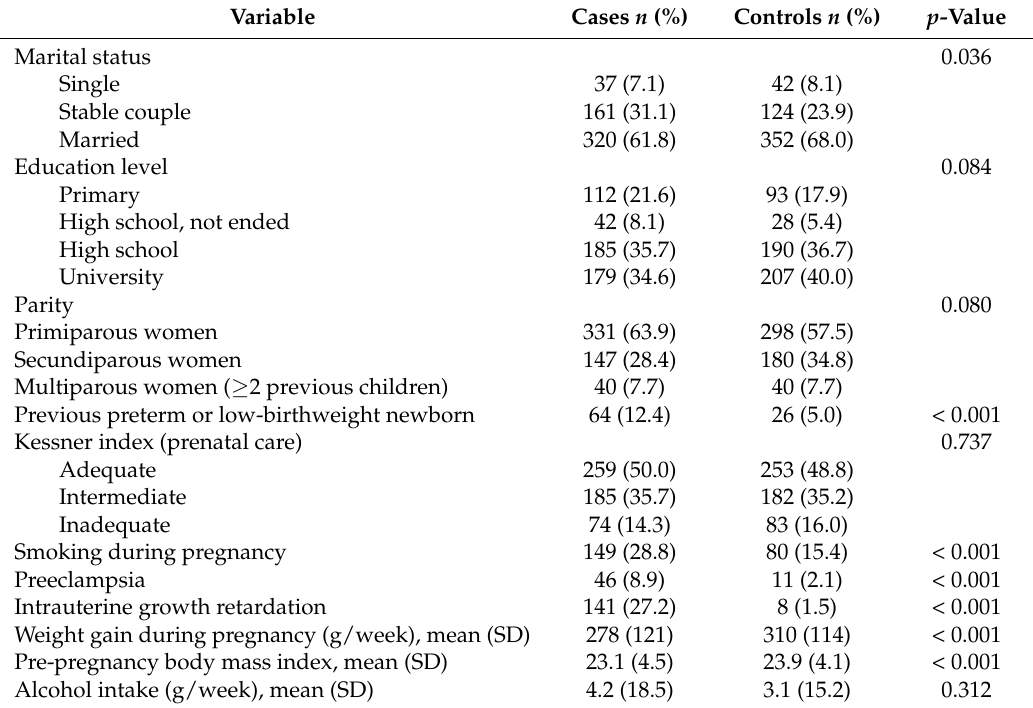
Table 1. Description of the study population.